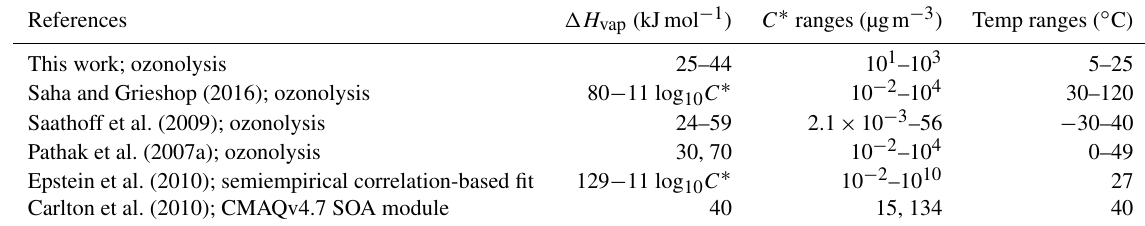
Table 2. Comparison of (cid:49)H vap in this study with previous